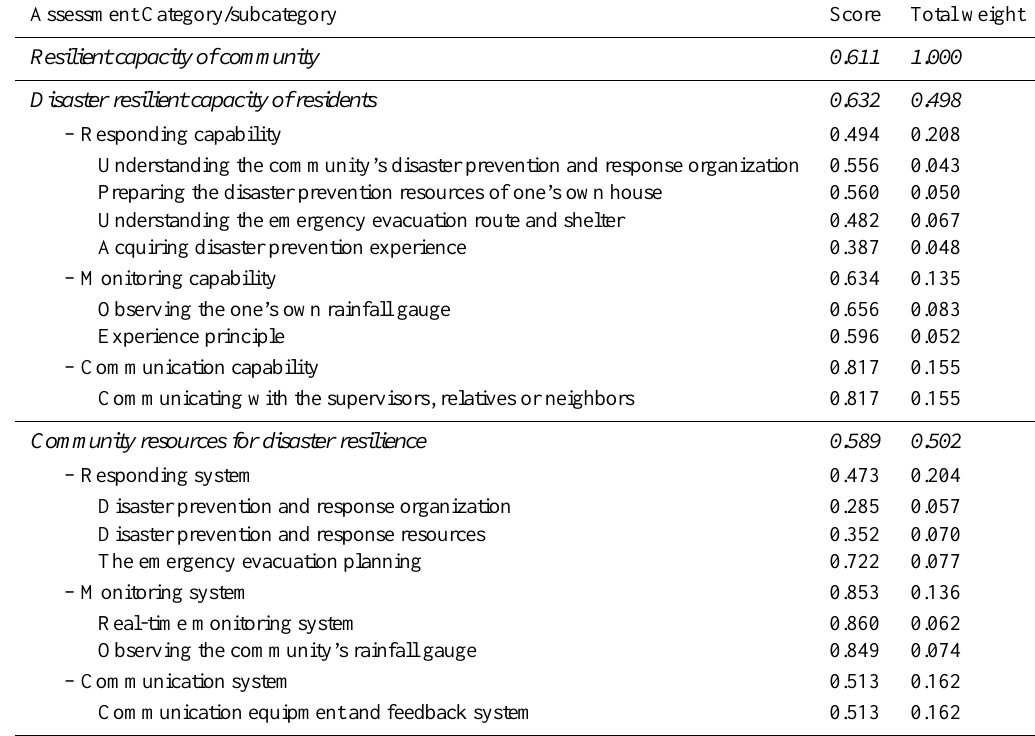
Table 3. Resilient capacity scores for the Songhe community.